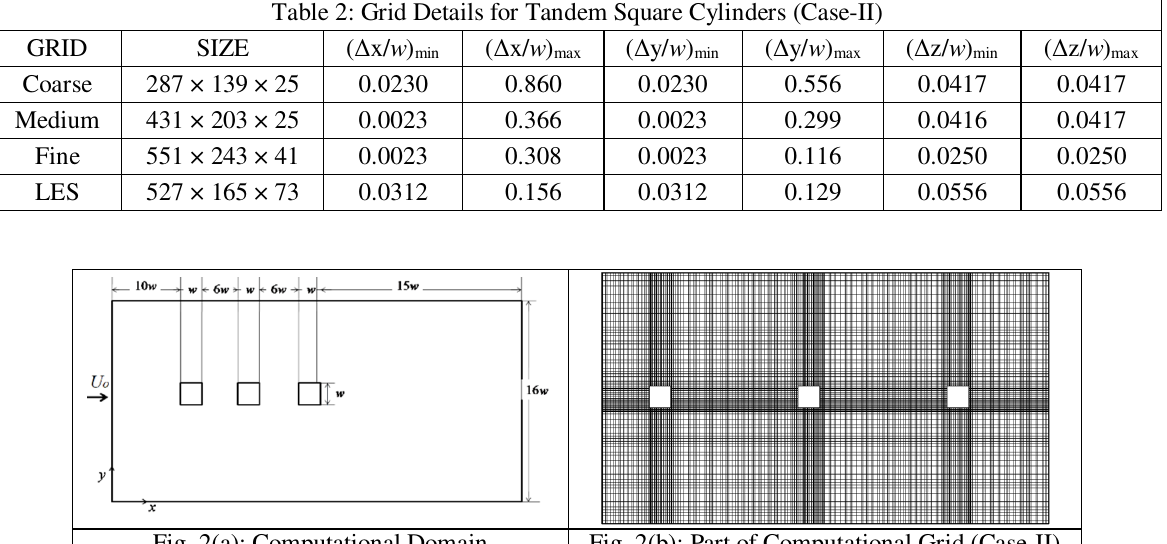
Fig. 2(a): Computational Domain Fig. 2(b): Part of Computational Grid